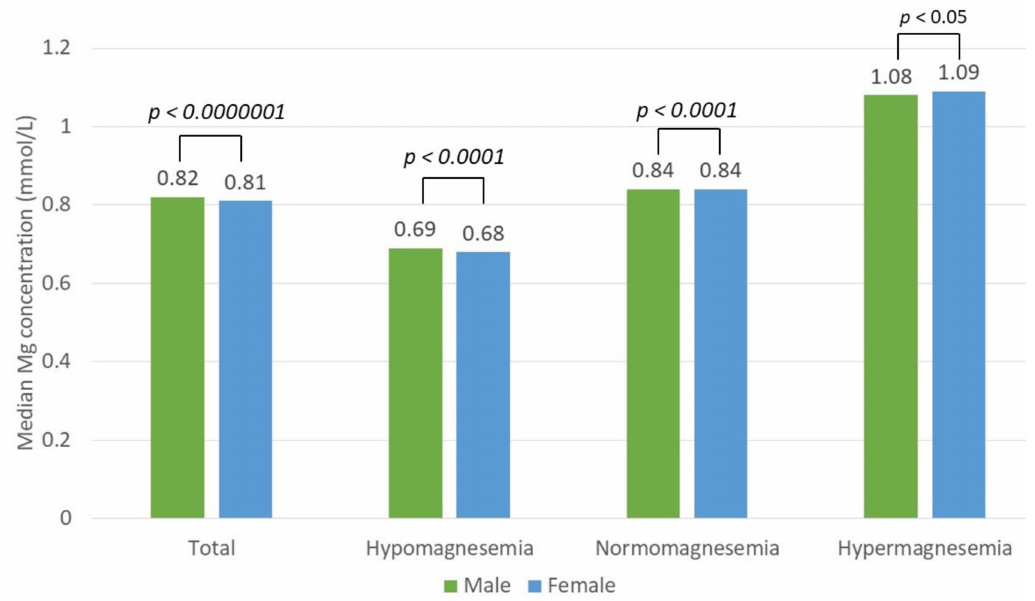
Figure 3. Median magnesium (Mg) concentration difference between sexes in the total patient and hypo-, normo-, and hypermagnesemia